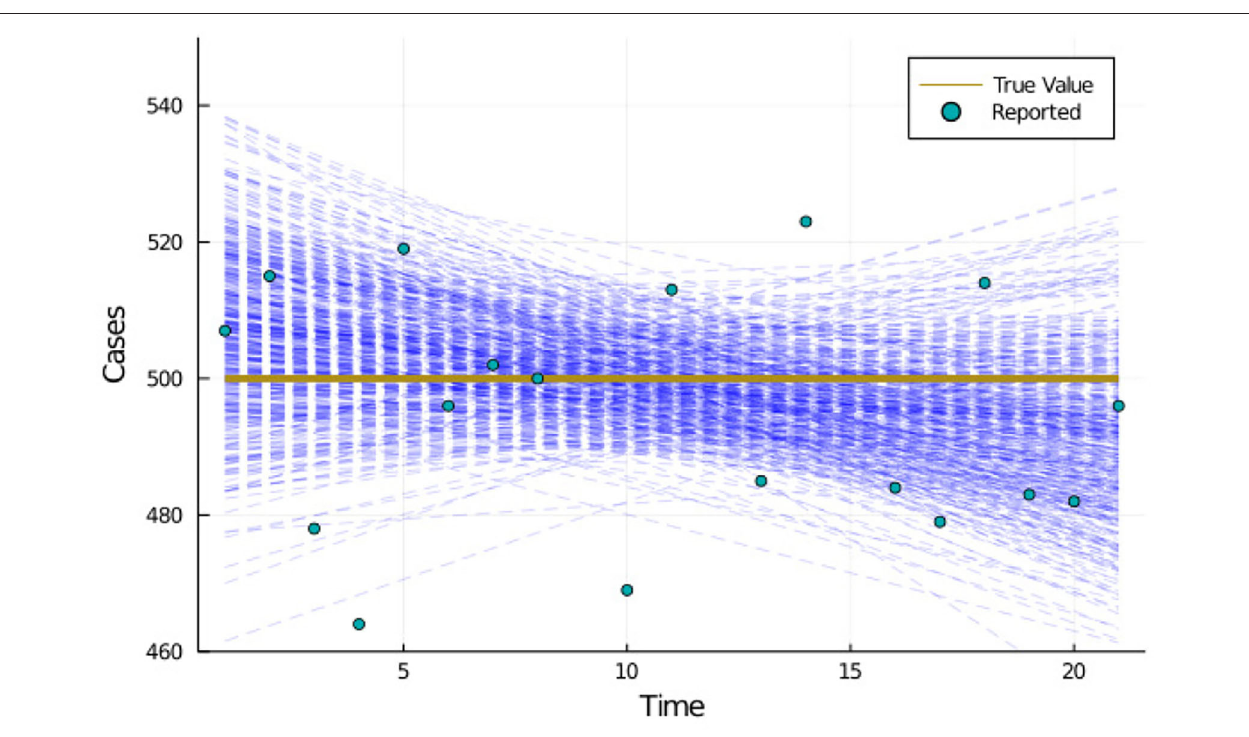
Frontiers in Applied Mathematics and Statistics |